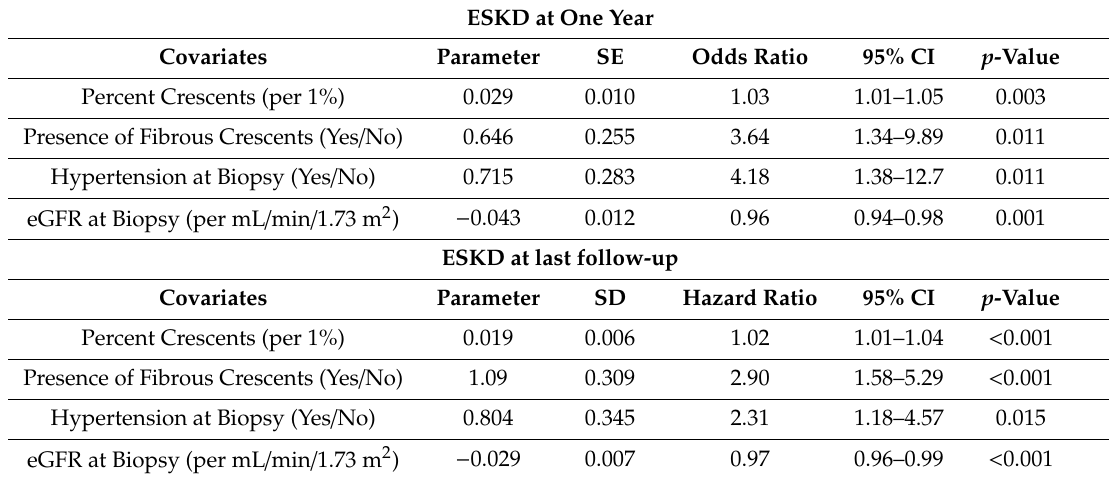
Table 2. Regression analysis of the association between clinical and histologic findings at the time of biopsy and ESKD at one year and last follow-up. ESKD at One Year Covariates Parameter